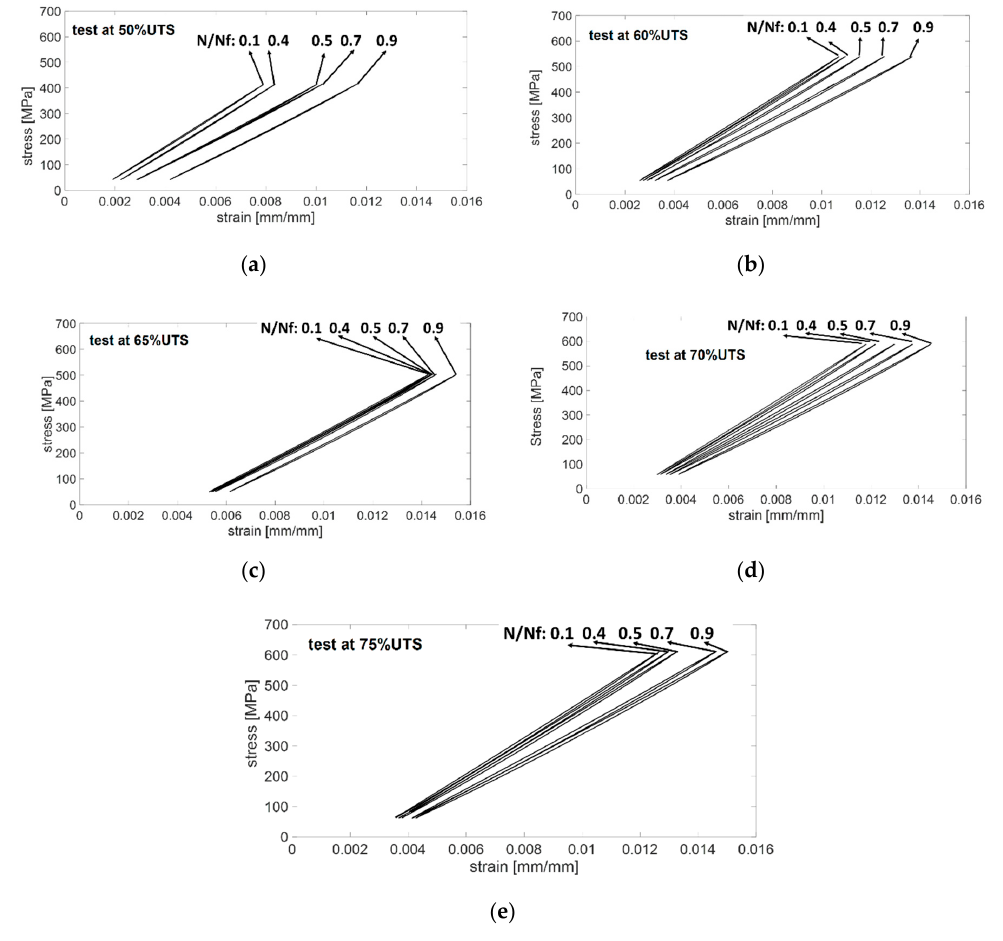
Figure 4. Hysteresis loops at ( a ) 50% UTS, ( b ) 60% UTS, ( c ) 65% UTS, ( d ) 70% UTS, and ( e ) 75% UTS. The area under the hysteresis loop per cycle has been evaluated according to the procedure that is presented in Section 4.1.